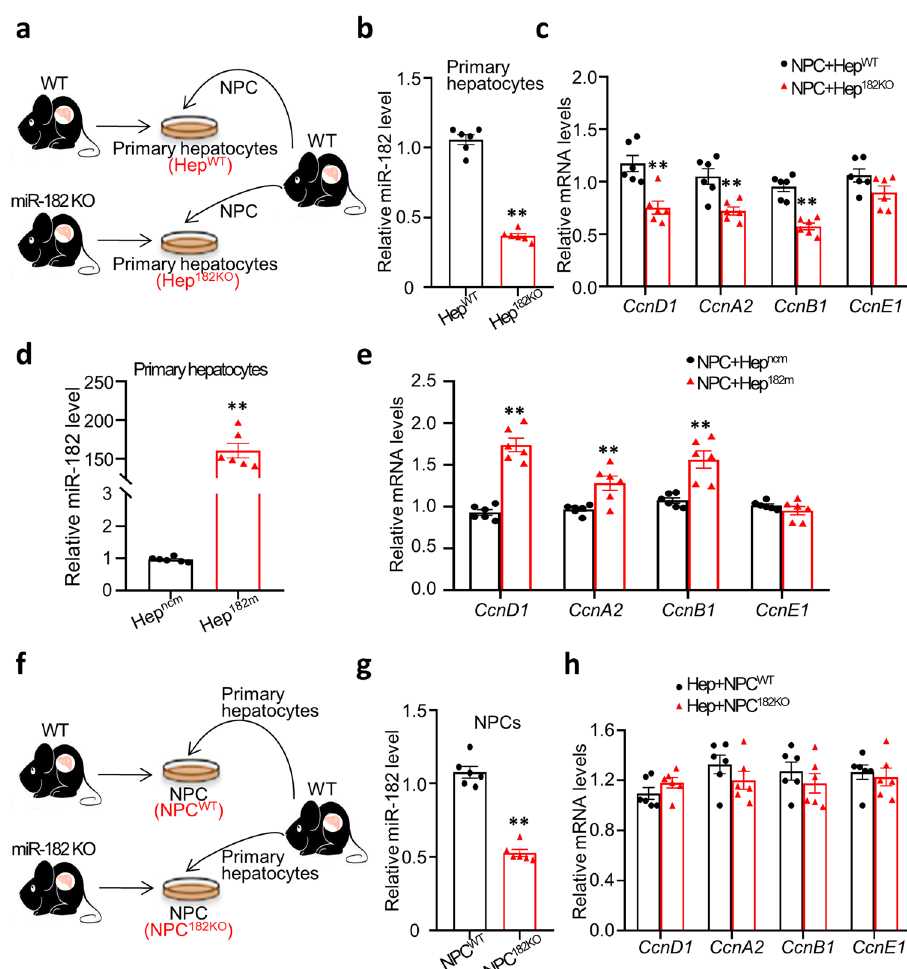
Fig. 3 miR-182-5p promotes hepatocyte proliferation via an indirect mechanism involving non-parenchymal cells. a A schematic diagram of primary hepatocytes from miR-182-5p KO and WT mice co-cultured with NPCs of C57BL/6 J mice in the presence of EGF. b The expression of miR-182-5p in primary hepatocytes from miR-182-5p KO (Hep 182KO ) and WT mice (Hep WT ) co-cultured with NPCs of C57BL/6 J mice ( n = 6/group). c qRT-PCR analyses of cyclin genes expression in primary hepatocytes from miR-182-5p KO mice and their control mice co-cultured with NPCs of C57BL/6 J mice ( n = 6/group). miR-182-5p mimic (182 m) or its negative control (ncm) were overexpressed in primary hepatocytes isolated from C57BL/6 J mice, and following co-cultured with NPCs of C57BL/6 J mice. d The expression of miR-182-5p in primary hepatocytes ( n = 6/group). e qRT-PCR analyses of cyclin genes expression in miR-182-5p-overexpressed (Hep 182 m ) and their control (Hep ncm ) primary hepatocytes co-cultured with NPCs of C57BL/6 J mice ( n = 6/group). f A schematic diagram of NPCs from miR-182-5p KO and WT mice co-cultured with primary hepatocytes of C57BL/6 J mice in the presence of EGF. g The expression of miR-182-5p in NPCs from miR-182-5p KO (NPC 182KO ) and WT mice (NPC WT ) co-cultured with primary hepatocytes ( n = 6/group). h qRT-PCR analyses of cyclin gene expression in primary hepatocytes co-cultured with NPCs from miR-182-5p KO mice and their control mice ( n = 6/group). Error bars in all experiments represent SEM; Signi fi cance was determined by unpaired two-tailed Student ’ s t test. ** P <